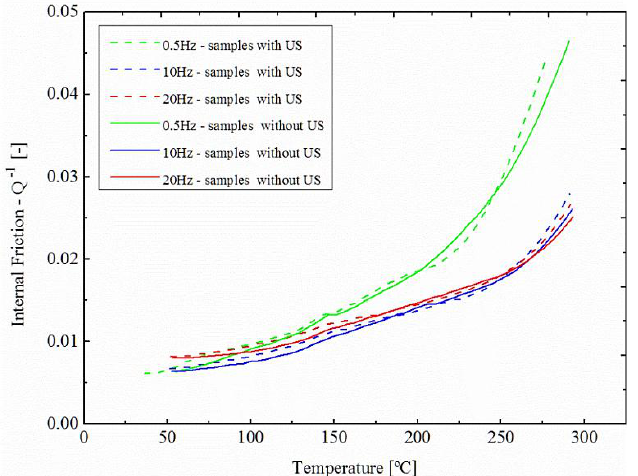
Figure 6. Internal friction ( Q −1 ) of as-cast